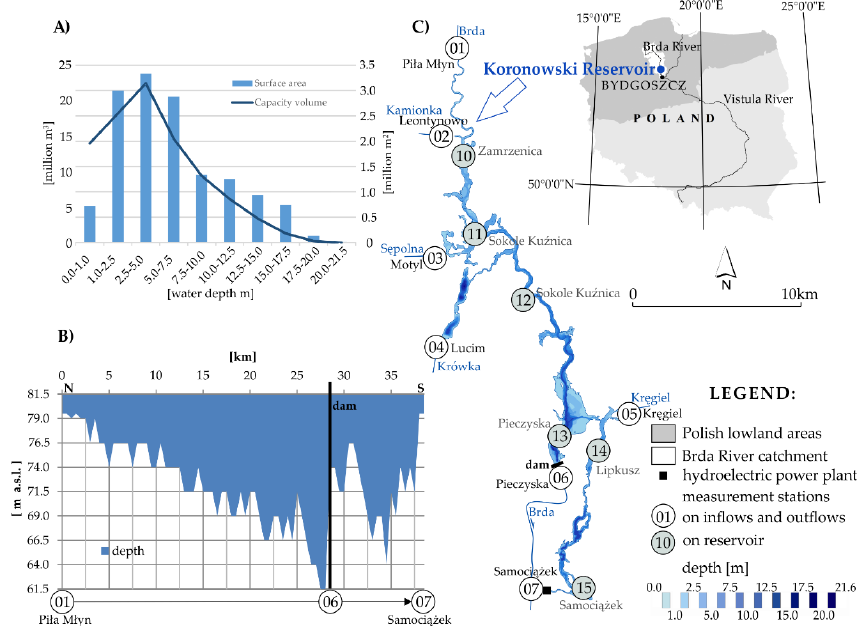
Figure 1. Location of measurement stations of suspended sediments of the Koronowski Reservoir catchment in the Polish lowlands [18,19]; 01–15 measurement stations (in grey on reservoir; in white on inflows and outflows), along with morphometric data: ( A ) Comparing surface area and capacity volume with depth; ( B ) longitudinal profile; and ( C ) bathymetry of the Koronowski